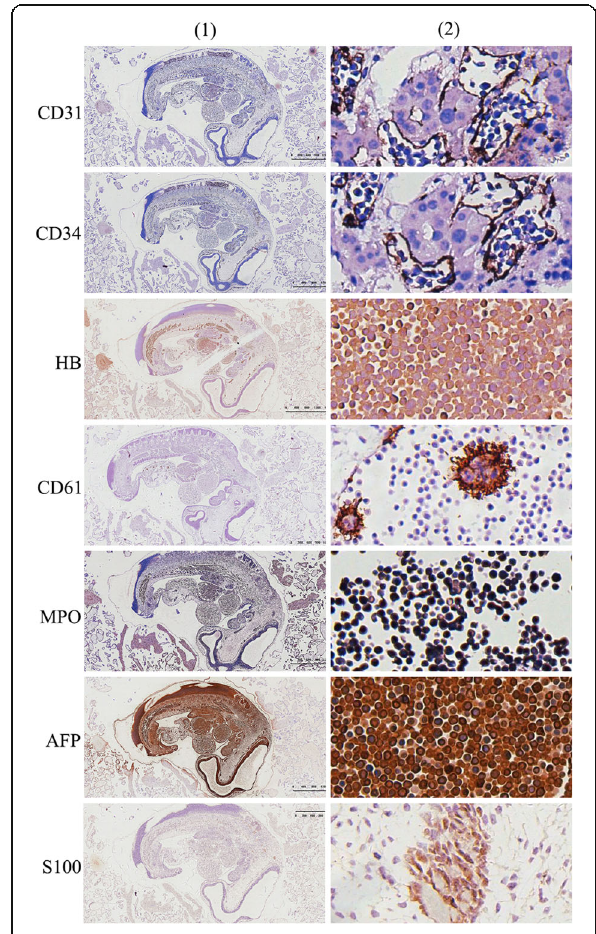
Fig. 2 Immunohistochemical positive staining in the early embryonic tissue and its extramedullary hematopoietic tissue. CD31 positive staining in the vascular endothelial cells, suggesting that all the extramedullary hematopoietic cells were located in the blood vessels or naive liver sinus; CD34 positive staining in the vascular endothelial cells, suggesting that all the extramedullary hematopoietic cells were located in the blood vessels or naive liver sinus; CD61 positive staining in megakaryocytic cells, confirming that the positive cells are megakaryocyte; MPO positive staining in extramedullary hematopoietic celsl in the blood vessels, confirming that the positive cells are medullary hematopoietic cells; AFP positive staining in the extramedullary hematopoietic cells; S-100 positive staining in the neural tube; (1): 10× magnification; (2): 200×